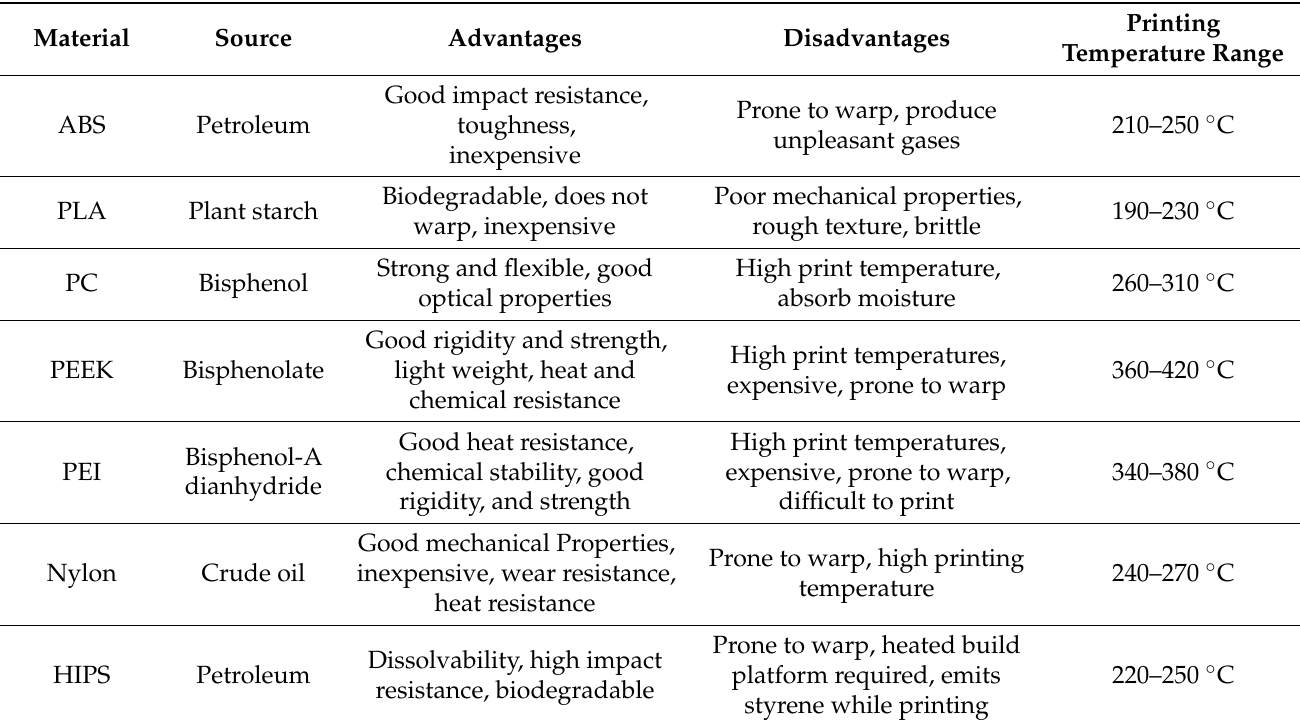
Table 3. The filament material for different applications should be selected based on the properties of materials while considering the purpose or the functionality of the printed parts. PLA-based filaments can be used for food packaging and medical implants. On the other hand, ABS and HIPS are useful for high-impact resistance applications. Nylon is a flexible, ductile, and durable filament material with good wear resistance. For aes- thetics purposes, typically, low-quality filaments are not an issue. The property analysis of filament materials is vital to select a material for a functional part. It should also be noted that the mechanical and thermal characterizations, electrical resistance, and fatigue behaviors of the filaments may vary from manufacturers and user. Many external factors contributing to this variation, such as the raw material quality, fabrication processes, the pre- and post-material treatments, or the testings conditions, are examples from the fila- ment manufacturers’ perspective. The state of the FFF equipment, the process parameters settings, the material handlings prior- and post-printing process, or the filament storage conditions are examples from the filament users’ perspective. Table 3. General properties of pure thermoplastic filament materials. ABS—acrylonitrile butadiene styrene,